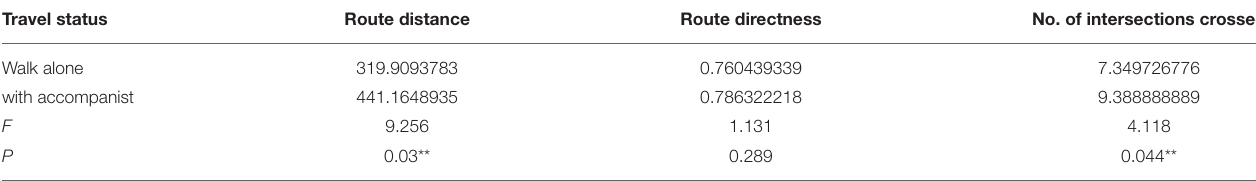
TABLE 5 | One-way ANOVA between travel status and network features.